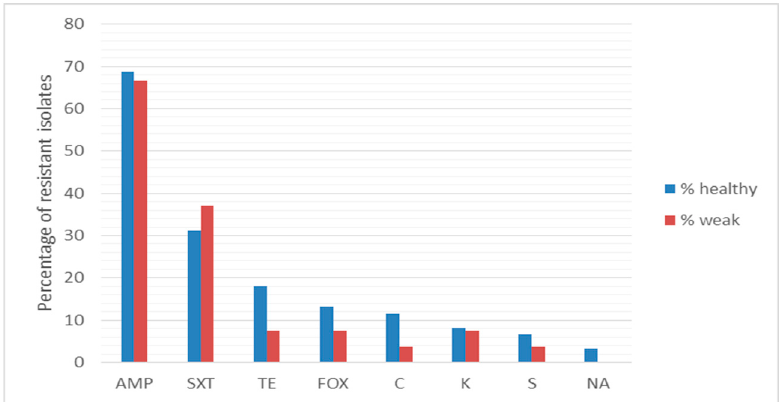
Figure 5. Percentage of antibacterial resistance of cloacal isolates from healthy and weak turtles. AMP, ampicillin; SXT, sulfamethoxazole/trimethoprim; TE, tetracycline; FOX, ciprofloxacin; CLO, chloramphenicol; KAN, kanamycin; STR, streptomycin, NAL, nalidixic acid.